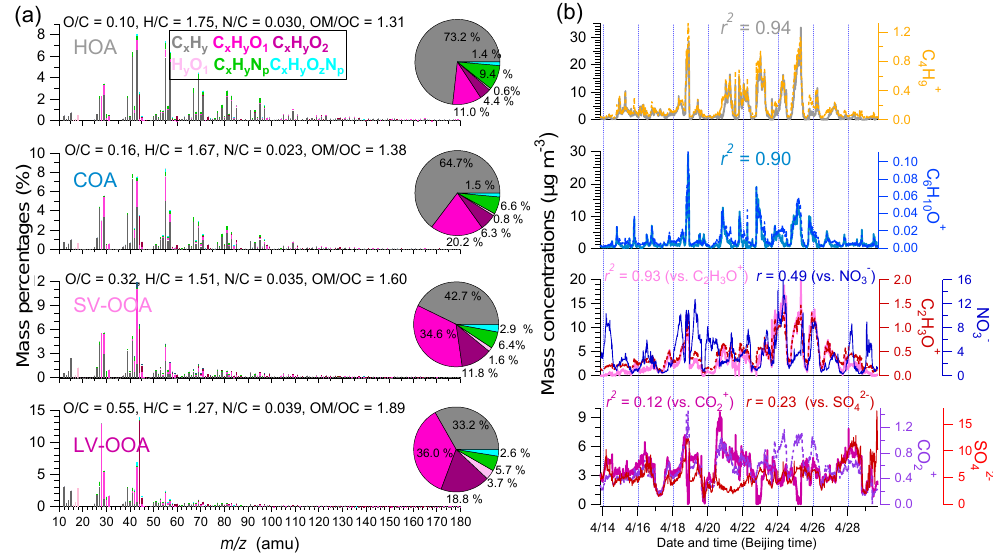
Figure 9. (a) High-resolution mass spectra of hydrocarbon-like OA (HOA), cooking-related OA (COA), semi-volatile oxygenated OA (SV- OOA), and low volatility oxygenated OA (LV-OOA) colored by six ion categories (the four inset pies show the relative contributions of the six ion categories to the four OA factors, respectively), (b) time series of the four OA factors, corresponding tracer ions, nitrate and sulfate. Table 1. Correlation coefficients (Pearson’s r 2 ) between the mass spectral profiles of the OA factors identified in this work with the corre- sponding factors identified in Beijing (2013 winter) (Sun et al., 2015a), Lanzhou (2014 summer) (Xu et al., 2014), and Fresno (2010 winter) (Ge et al., 2012b).